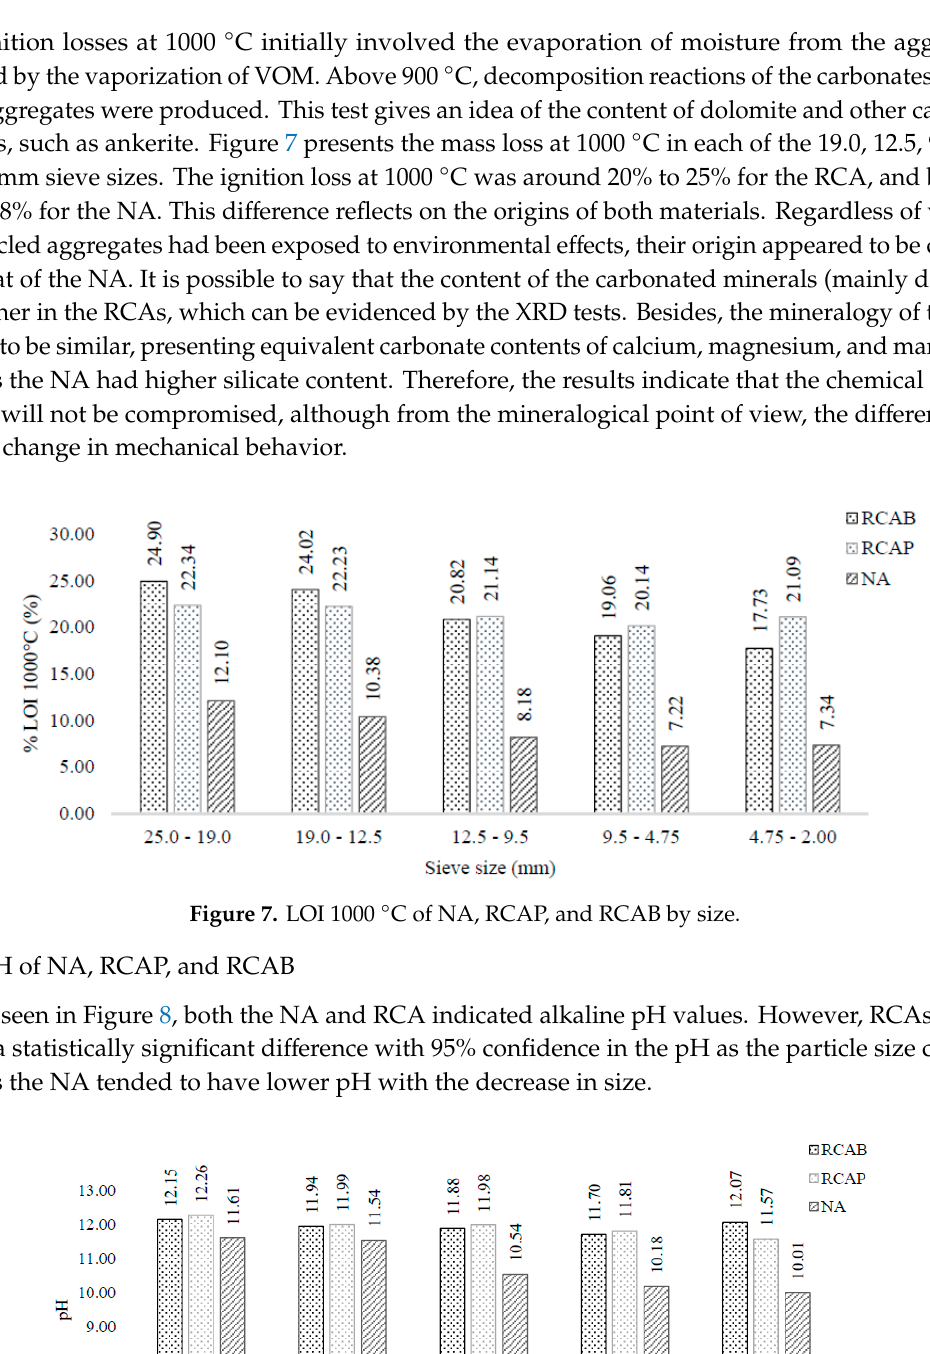
Figure 6. LOI550 °C of NA, RCAP, and RCAB by size.